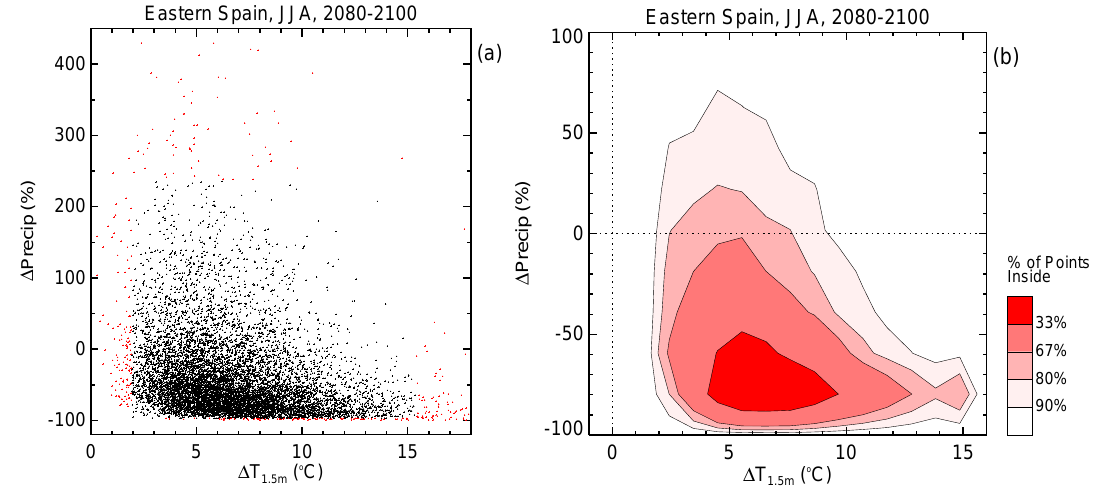
Fig. 6. (a) Scatter plot of 10000 sampled data points from the joint PDF of surface temperature change and percentage precipitation change for the summer season for Eastern Spain, for the period 2080–2099 relative to the 1961–1990 baseline period. Points that lie in the top and bottom 1% of the marginal distributions are shown in red. (b) Contours of the Winsorised sampled joint probability distribution function in (a).